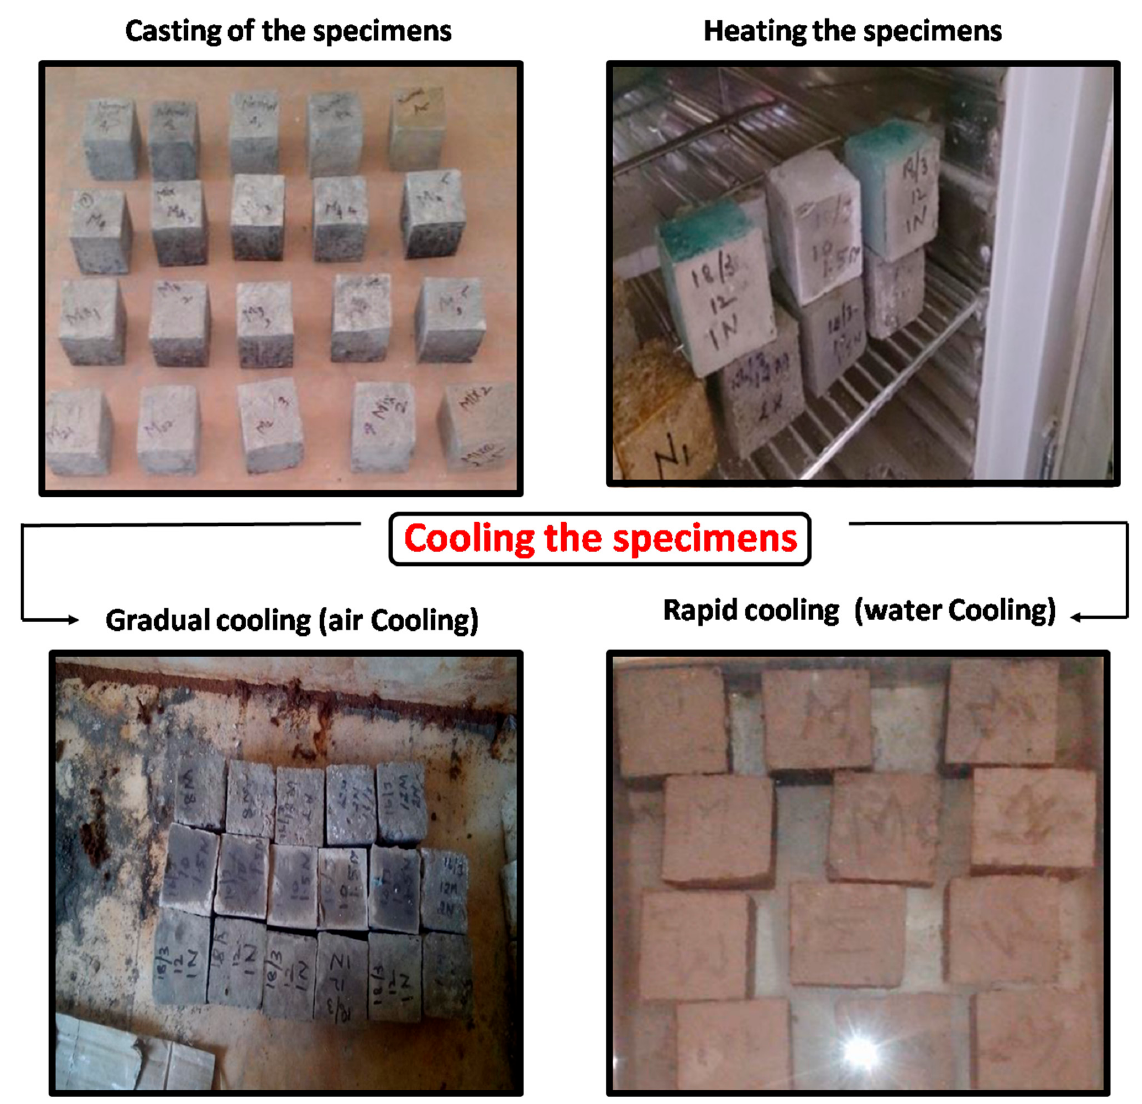
Figure 4. Self-compacting glass mortar specimens.